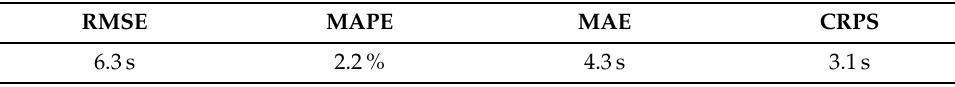
Table 1. Final model accuracy assessment based on predictions performed on the test